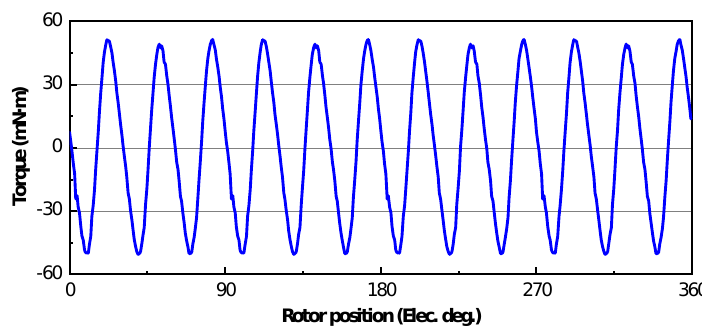
Figure 5. Relationship between cogging torque and rotor